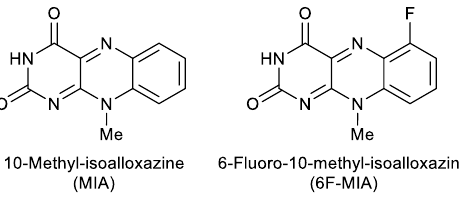
Figure 1. 10-Methyl-isoalloxazine (MIA) and the mono-fluorinated derivative 6-fluoro-10-methyl- isoalloxazine (6F-MIA) [17].